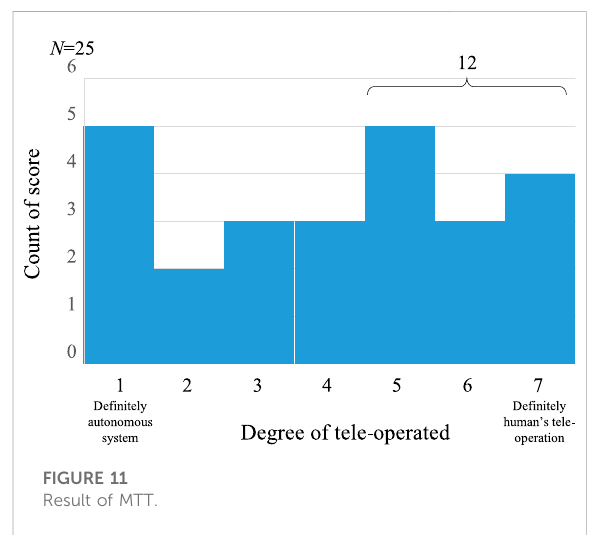
FIGURE 11 Result of